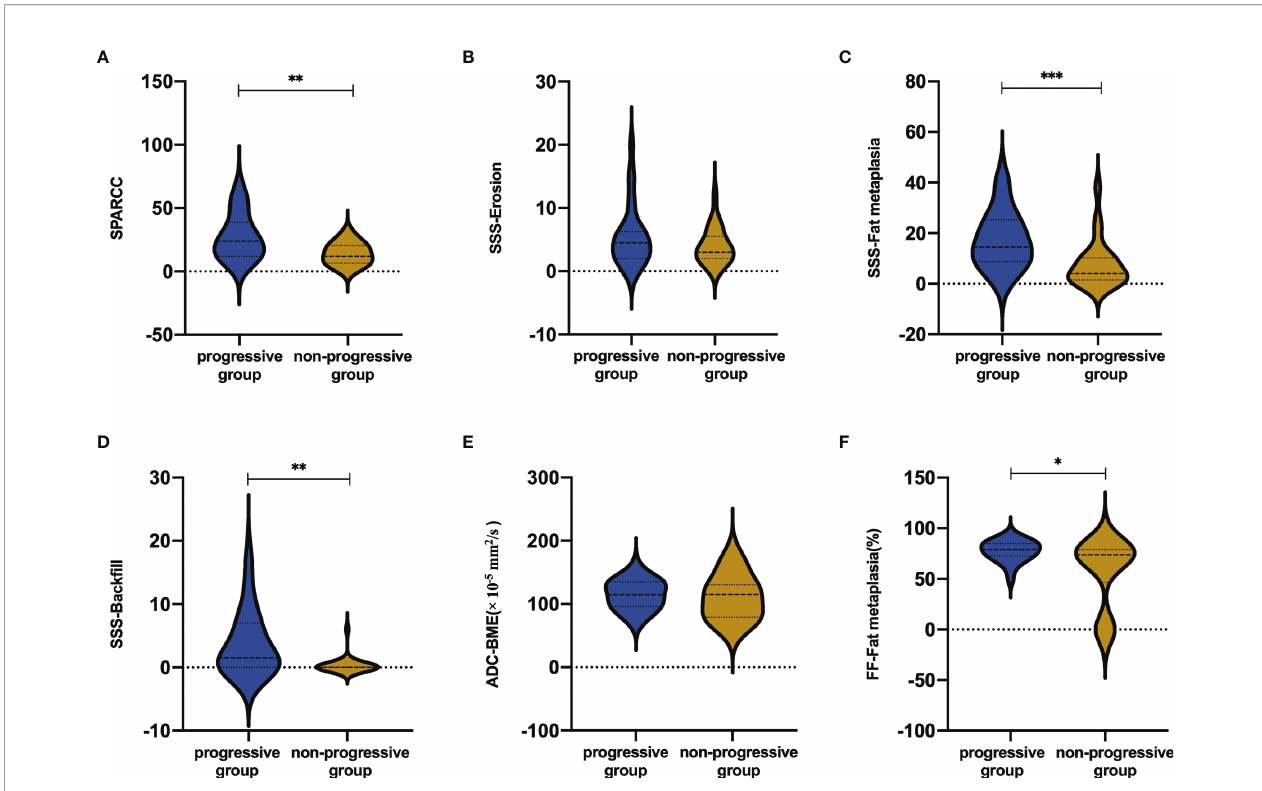
FIGURE 4 | Mean scores in (A) BME, (B) erosion, (C) fat metaplasia and (D) back fi ll according to back fi ll progression or not. Mean values in (E) ADC and (F) FF values according to back fi ll progression or not. BME ranges in score from 0 to 72. Erosion and fat metaplasia range in score from 0 to 40. Back fi ll ranges in score from 0 to 20. * P < 0.05; ** P < 0.01; *** P <